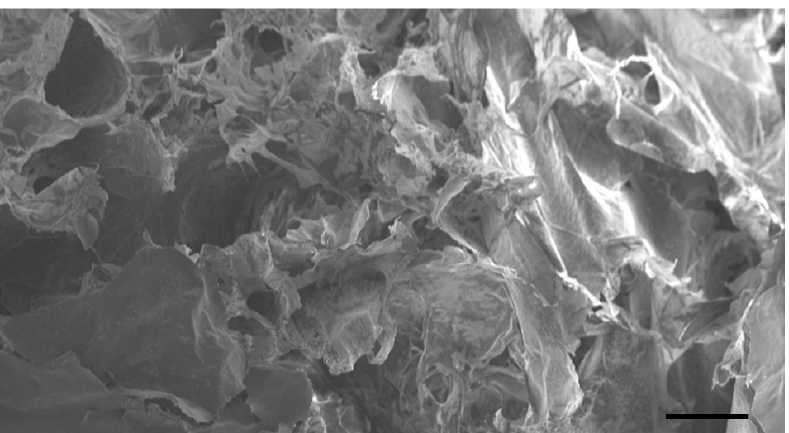
Figure 1. Fibrin construct. Fibrin gel (1 mL) was freeze-dried (Virtis SP Scientific BenchTop Pro, Warminster, PA, USA) for 48 h at 264 μ Bar at − 50 °C , the sample was then prepared for SEM with a chromium coating of 10nm thickness. SEM was performed with Zeiss Gemini equipment at 5 kV. The scale bar is 200 μ